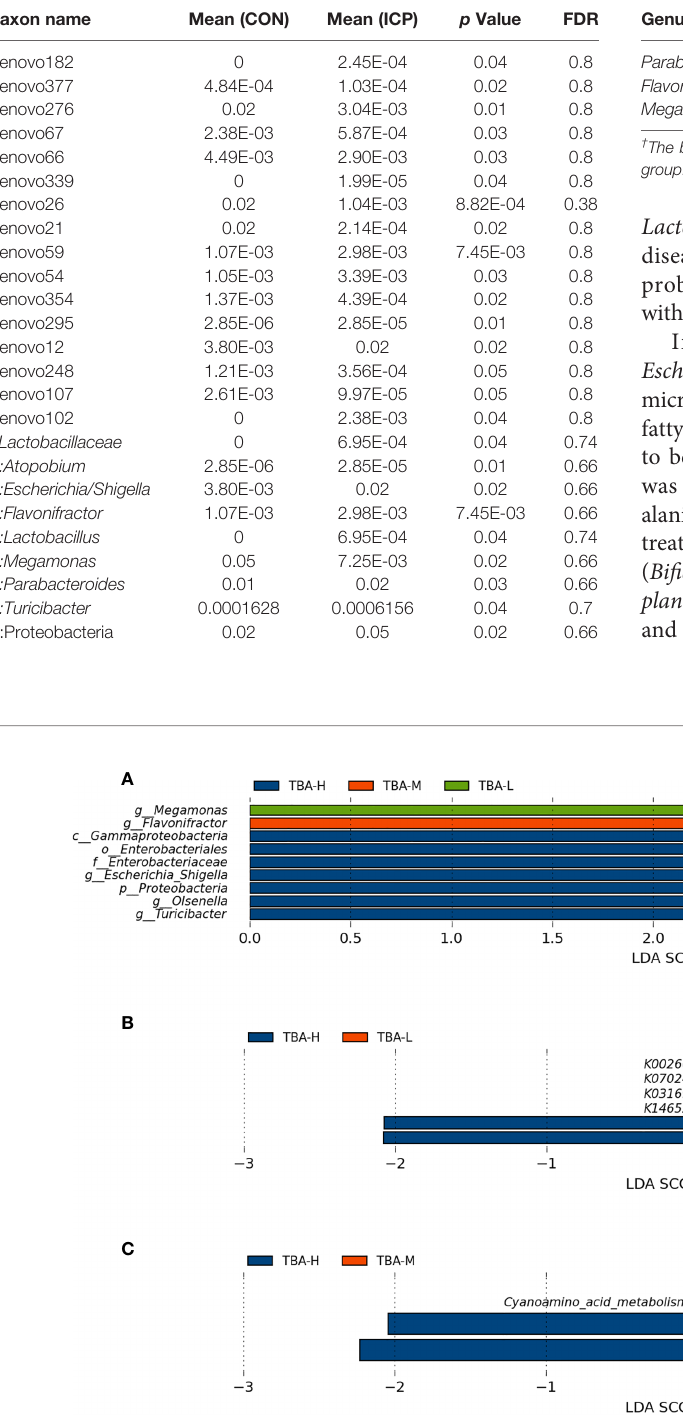
FIGURE 3 | Relationship between severity of ICP and microbiota. (A) Taxonomic differences in the microbial 16S rRNA gene through LEfSe analysis. (B) Signi fi cantly different KOs were detected in the microbiome of the mild and severe ICP groups. (C) The microbial gene functions related to the severity of ICP were detected in the level 3 KEGG pathways. KO, KEGG (Kyoto Encyclopedia of Genes and Genomes) orthologs; Blue, red, and green squares represent the severe ICP, mild ICP, and healthy controls,